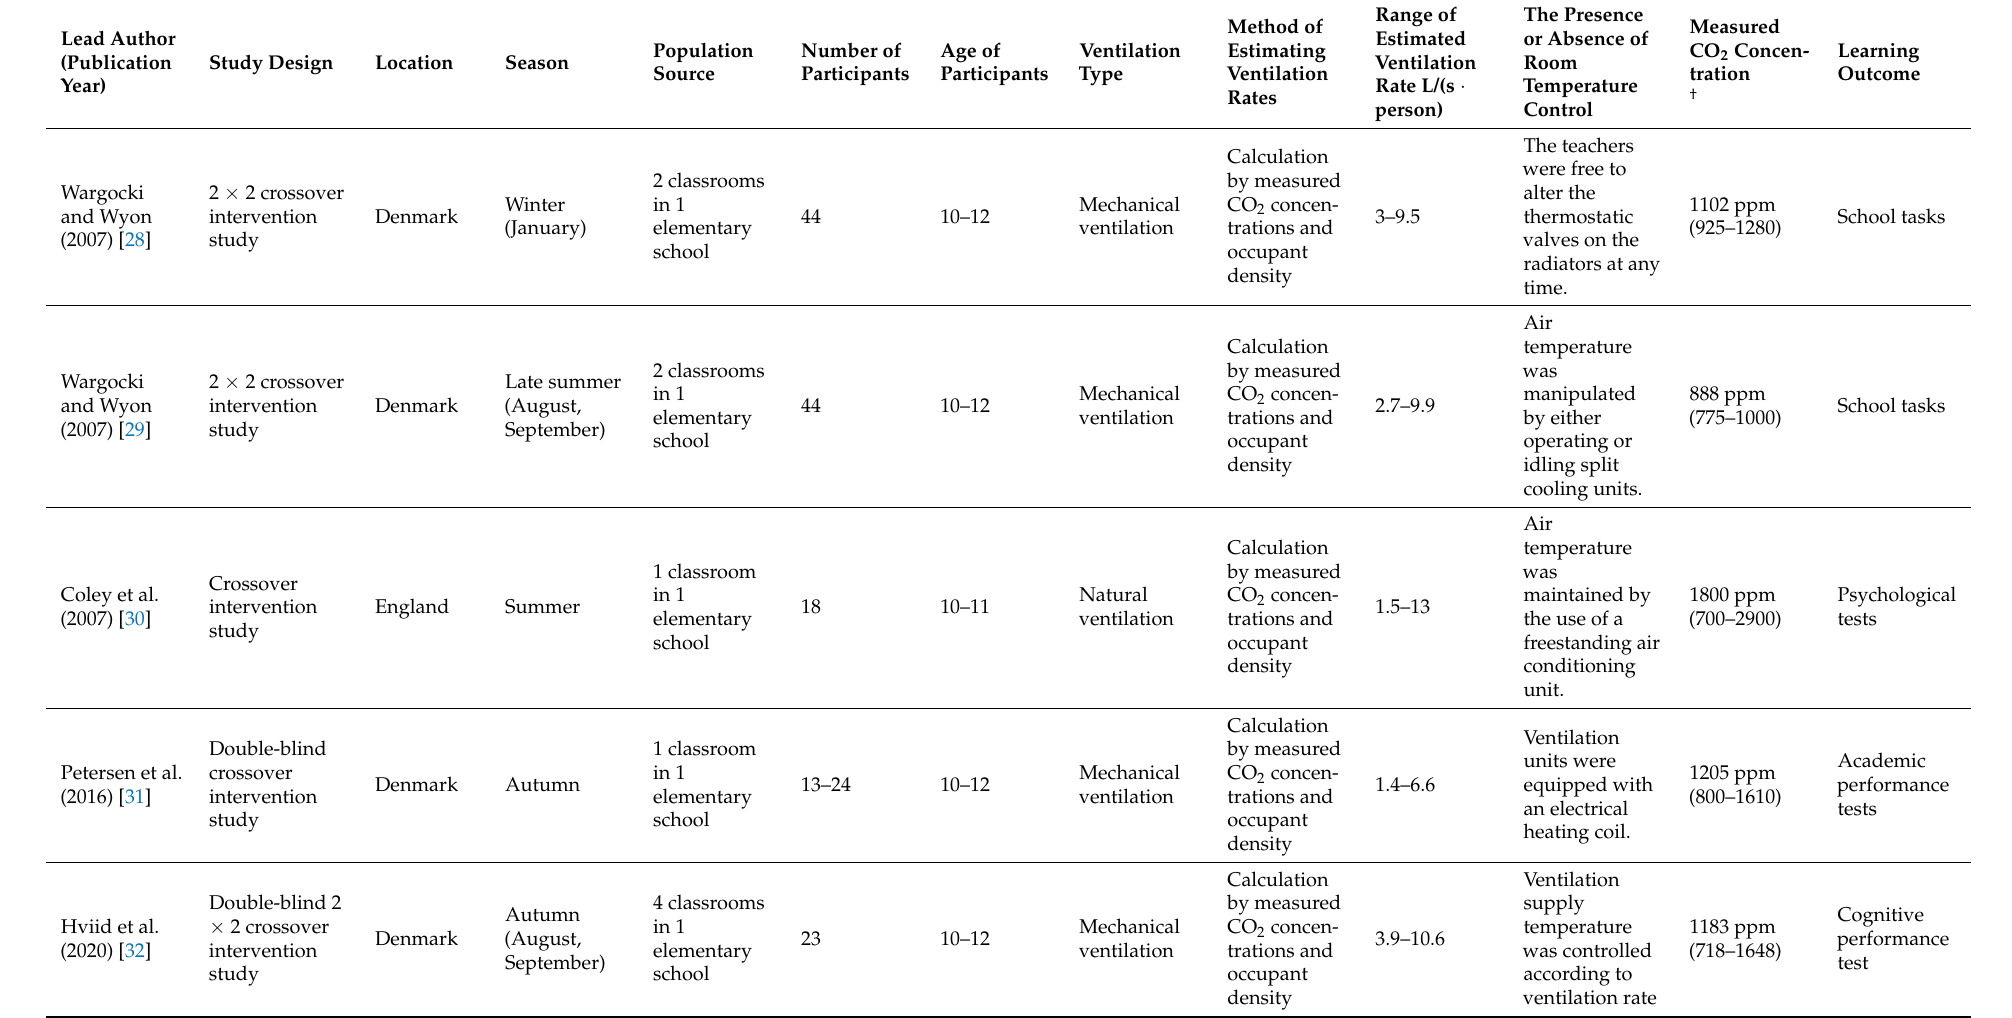
Table 1. Summary of studies included in the meta-analysis. † Reported as average concentration